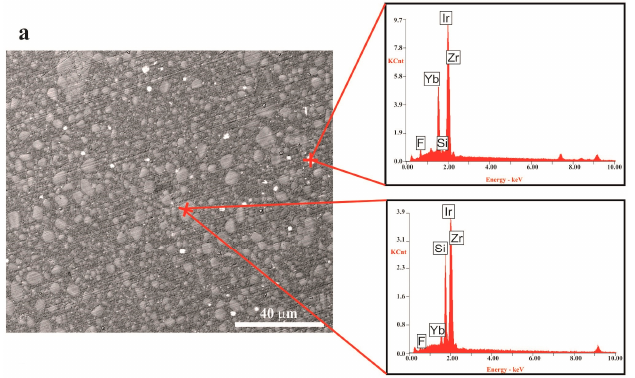
Figure 3. Cont. Figure 3.